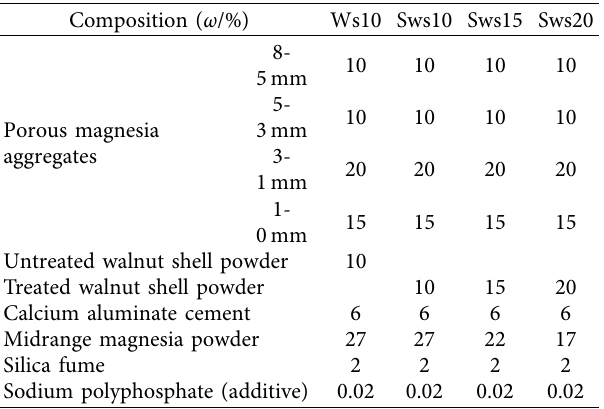
Table 3: Samples’ proportioning scheme.